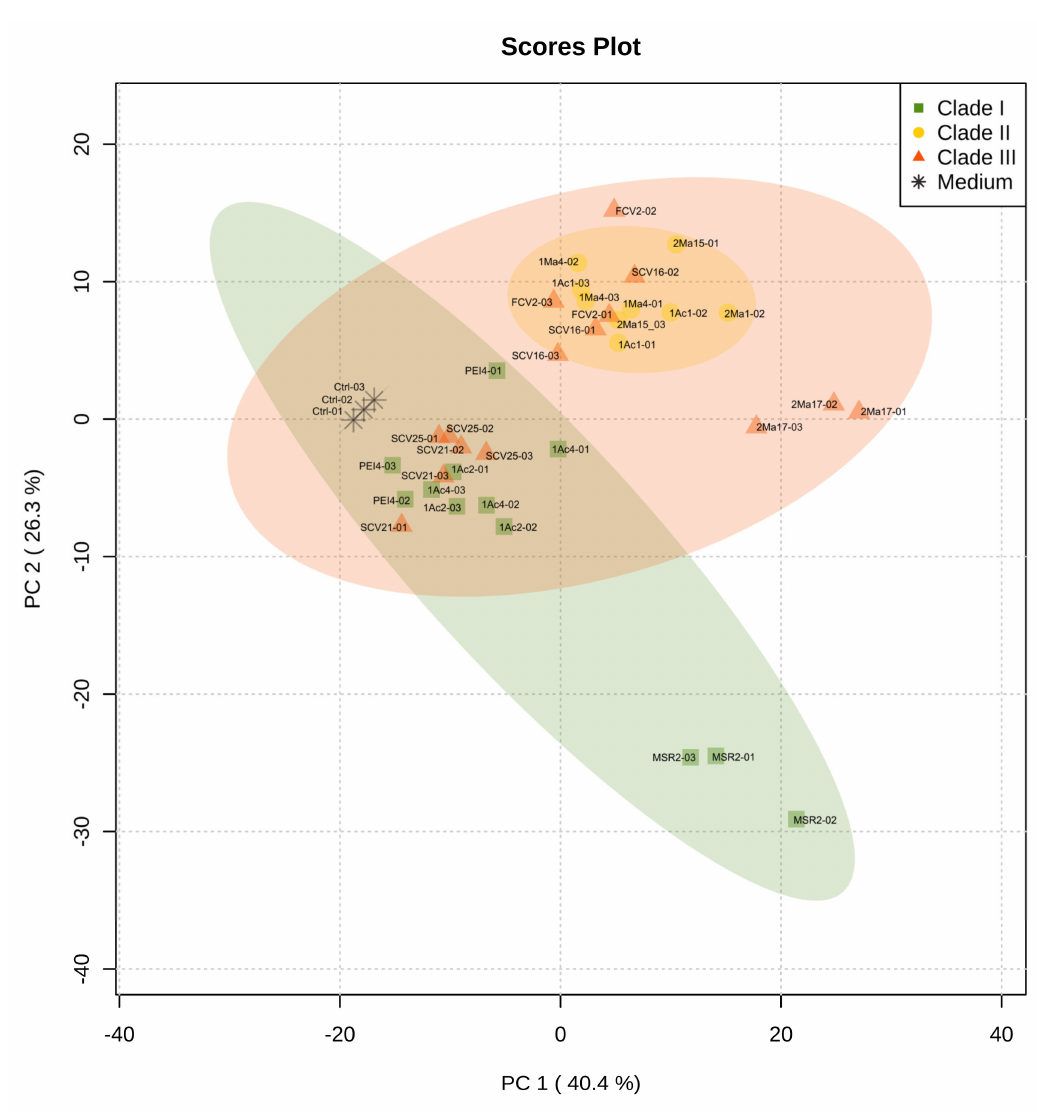
Figure 4. Principal component analysis (PCA) obtained from DIESI-MS analysis of culture extracts of the rhizosphere Burkholderia sensu lato strains. Different colored symbols represent the phylogenetic clustering resulting from previous 16S rRNA analysis: green squares (clade I), yellow circles (clade II) and orange-red triangles (clade III). Black asterisks correspond to uninoculated M9 medium